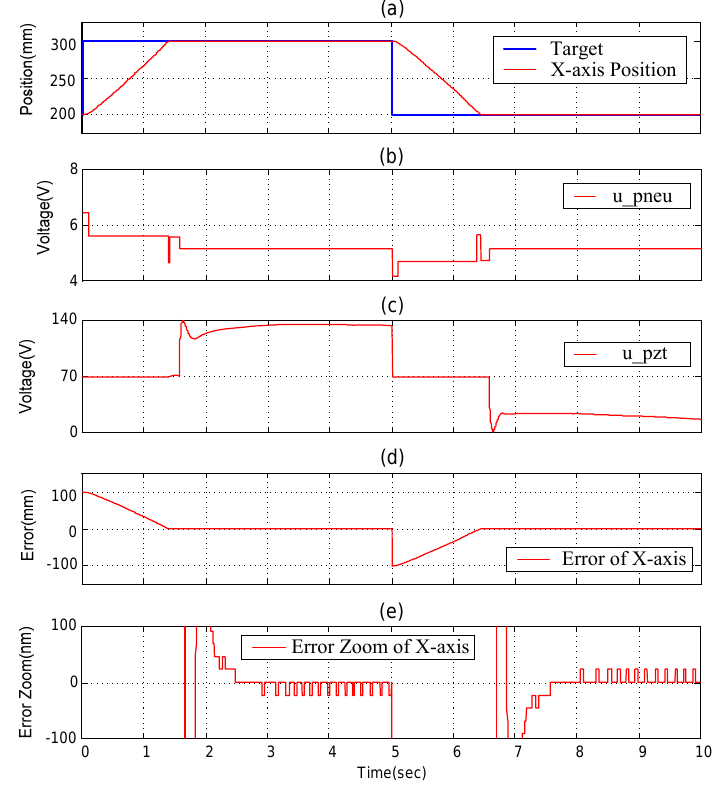
Figure 10. Experimental results of bi-directional position control of the pneumatic- piezoelectric hybrid actuator for single axis with stroke of 100 mm by DSOFSMC: (a) position control response, (b) pneumatic control signal, (c) piezoelectric control signal, (d) position control error, (e) error